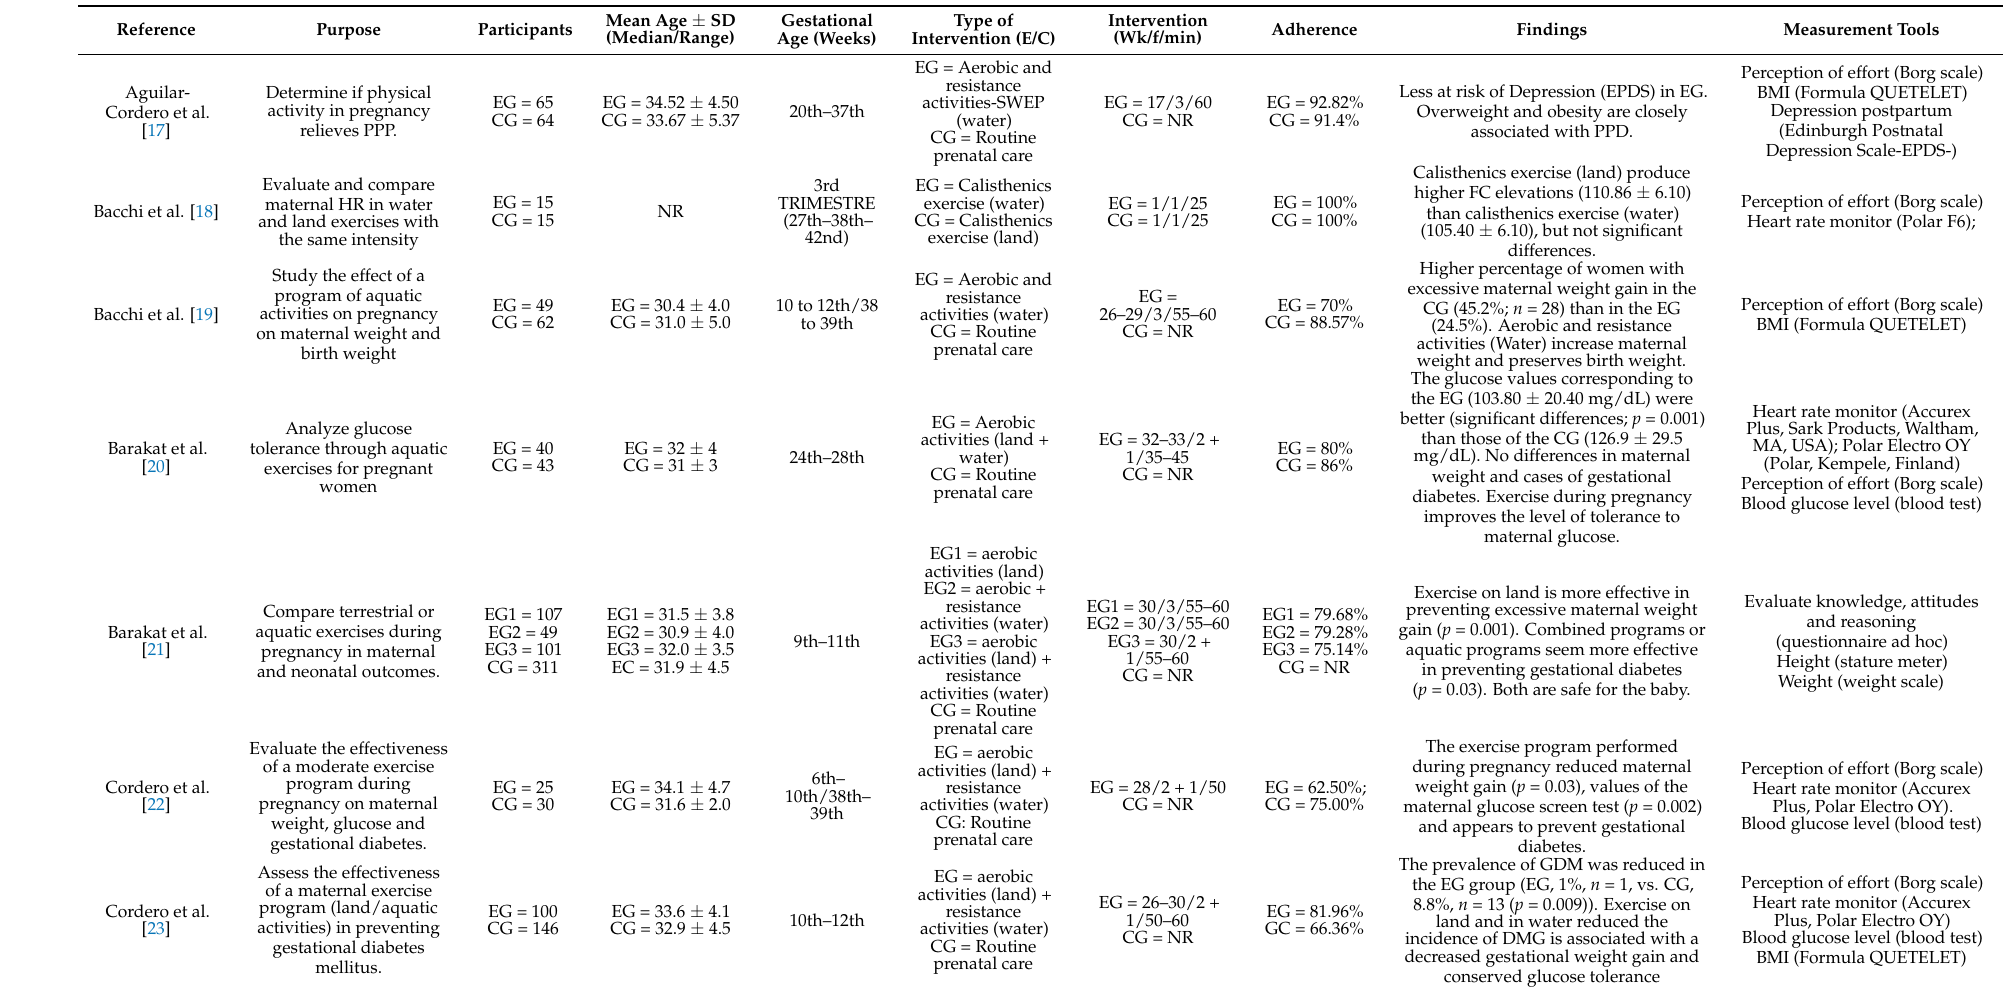
Table 1. Key characteristics of studies ( n = 17) included in the